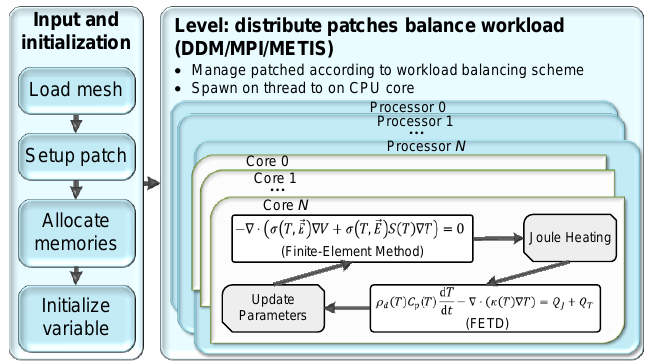
Figure 5. Hierarchical structure of the developed parallel